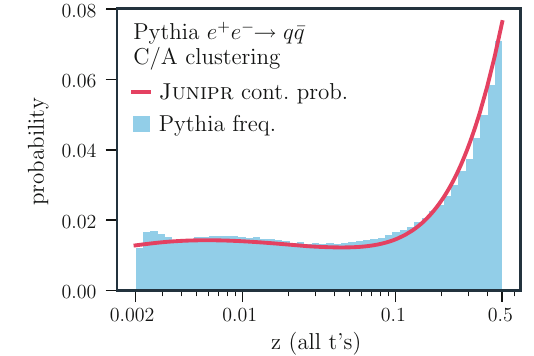
Fig. 10 Branching function modelled by a deep undirected energy modelovercontinuousvariables z ,θ,φ,δ thatparameterizethebranch- ing. Shown is the marginalized distribution over z , averaged over all t steps. Comparison is made between actual outcomes in the validation set of Pythia jets and Junipr ’s probabilistic predictions for these jets Then the percent-error (cid:9) in our biased estimate of the